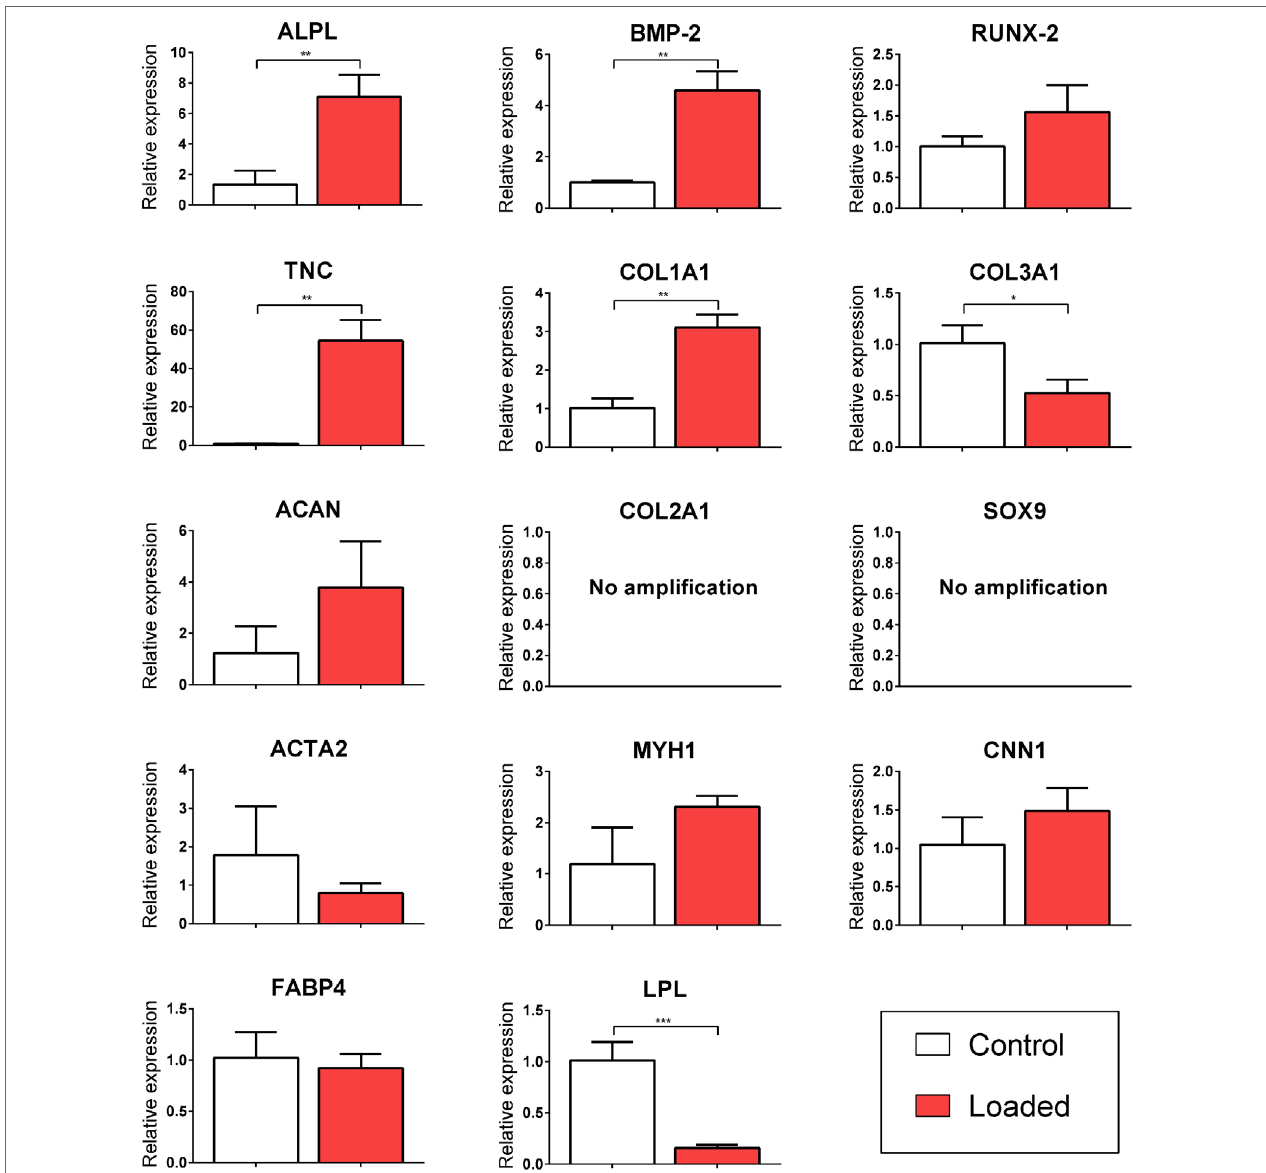
FigUre 2 | Relative gene expression of multipotent stromal cells (MSCs) encapsulated in fibrin hydrogels and cultured in tensile strain bioreactor in the absence of growth factors for 7 days. The application of 10% cyclic tensile strain at 0.5 Hz was found to promote intramembranous ossification and inhibit adipogenic differentiation of MSCs. Data are presented as fold changes, relative to the non-loaded (control) group. Significant differences are indicated where present (* p < 0.05; ** p < 0.01; *** p < 0.001; n = 5). See Table 1 for details of gene